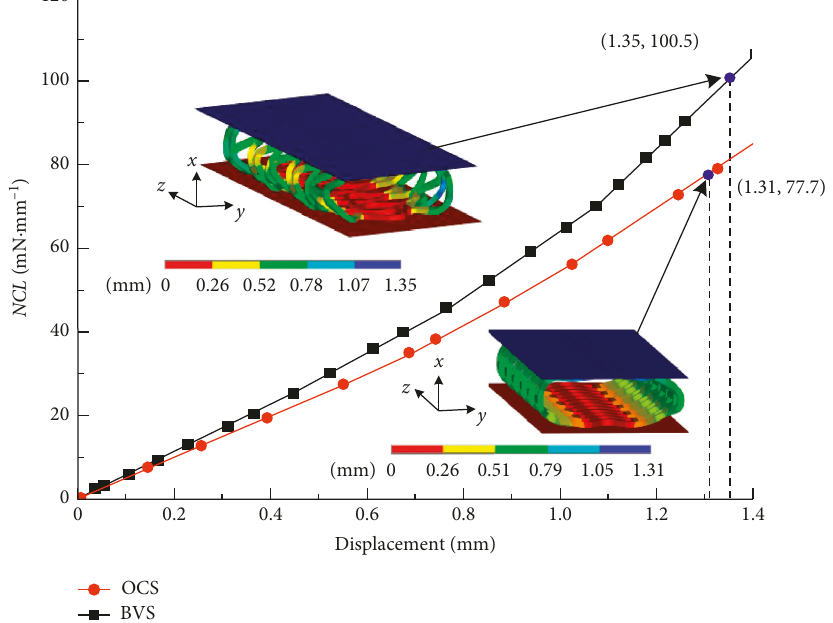
Figure 16: Normalized compressive load-displacement curves of the OCS and BVS during FEA.